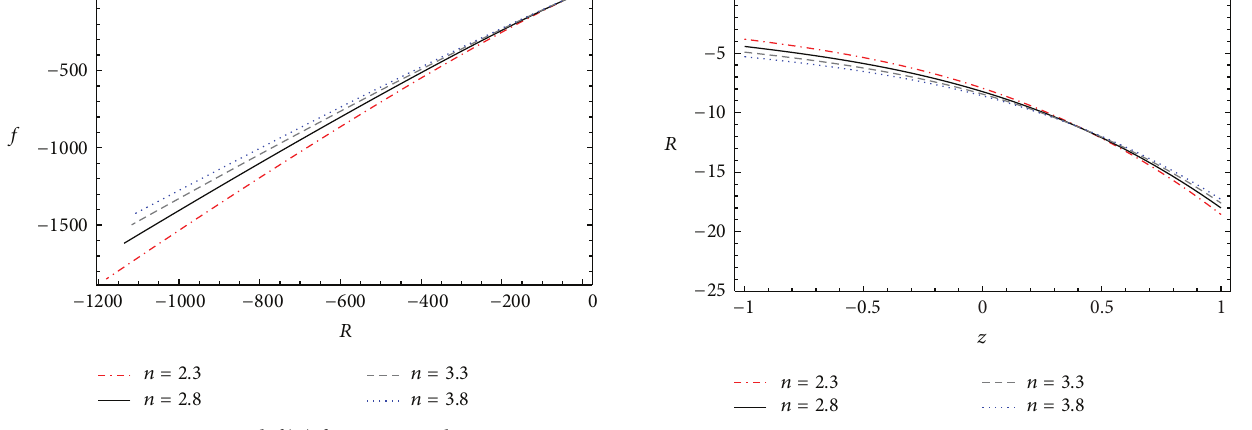
Figure 3: Future evolution of 𝑅 in NADE with −1 ≲ 𝑧 ⩽ 1 .